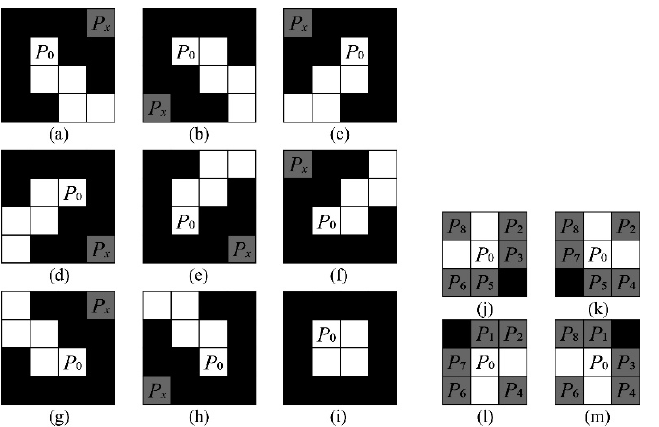
Figure 9. The retention templates and the deletion templates. ( a – i ) The retention templates in different directions. ( j – m ) The deletion templates in different directions. The pixels of scanning points are marked as P 0 , and pixel sets P x of 8 neighborhoods and 24 neighborhoods are constructed, where x = 1, 2, . . . 24. The pixel P x in the gray square can be either 1 or